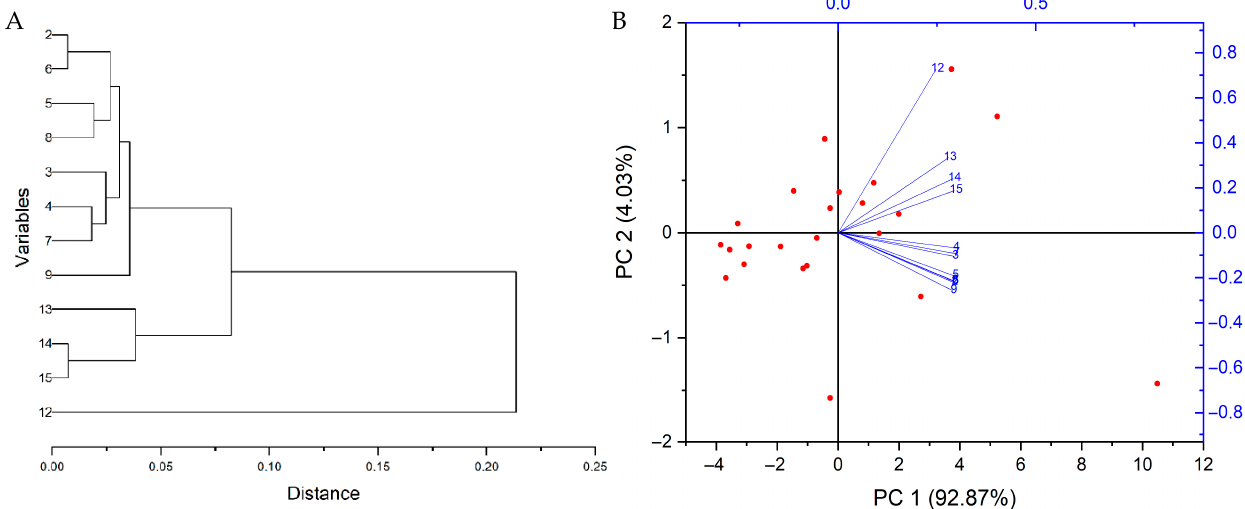
Figure 5. Statistical analyses for nitrate nitrogen (NO 3 -N): HCA ( A ) and PCA ( B ; this research).